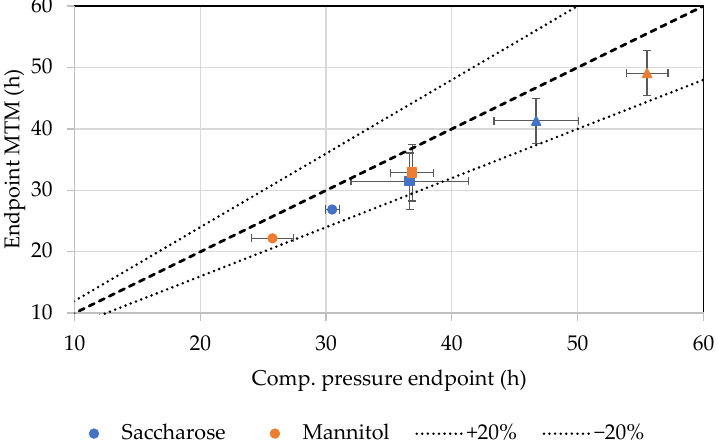
Figure 12. Primary drying endpoint of MTM and comparative pressure measurement (round—5 g/L, square—25 g/L, and triangle—100 g/L).